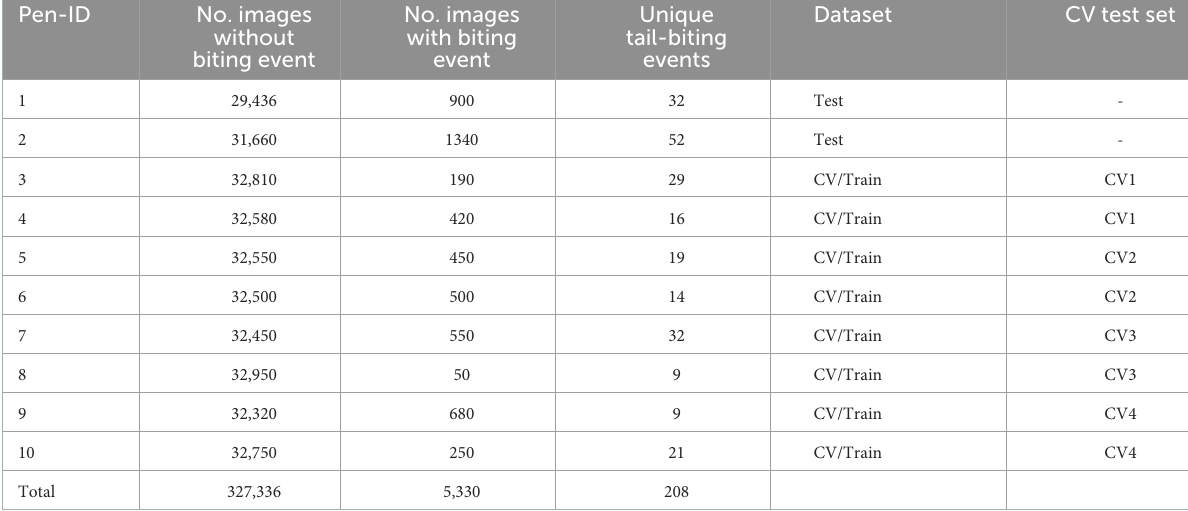
TABLE 2 Descriptive statistics of dataset (CV, Cross-validation).